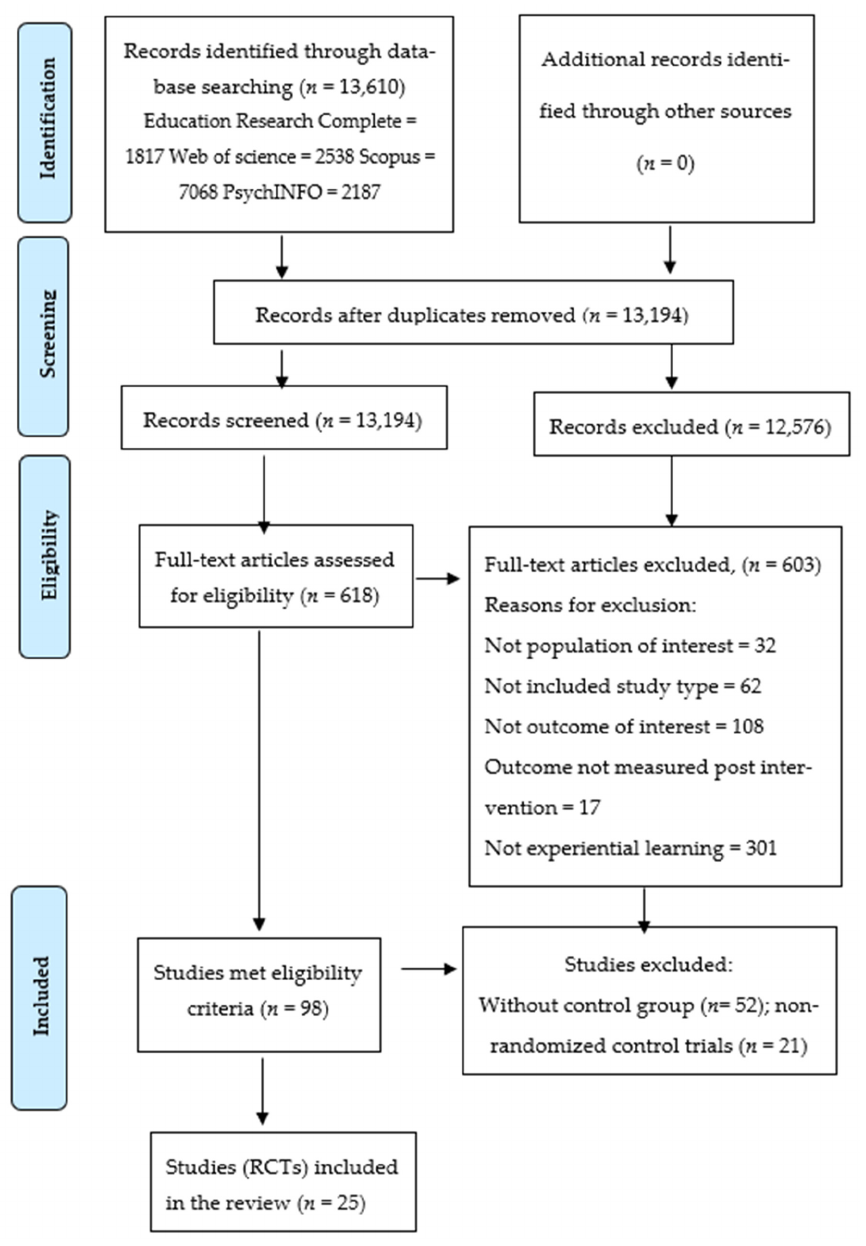
Figure 1. Flow chart of the study selection process. (PRISMA flow diagram